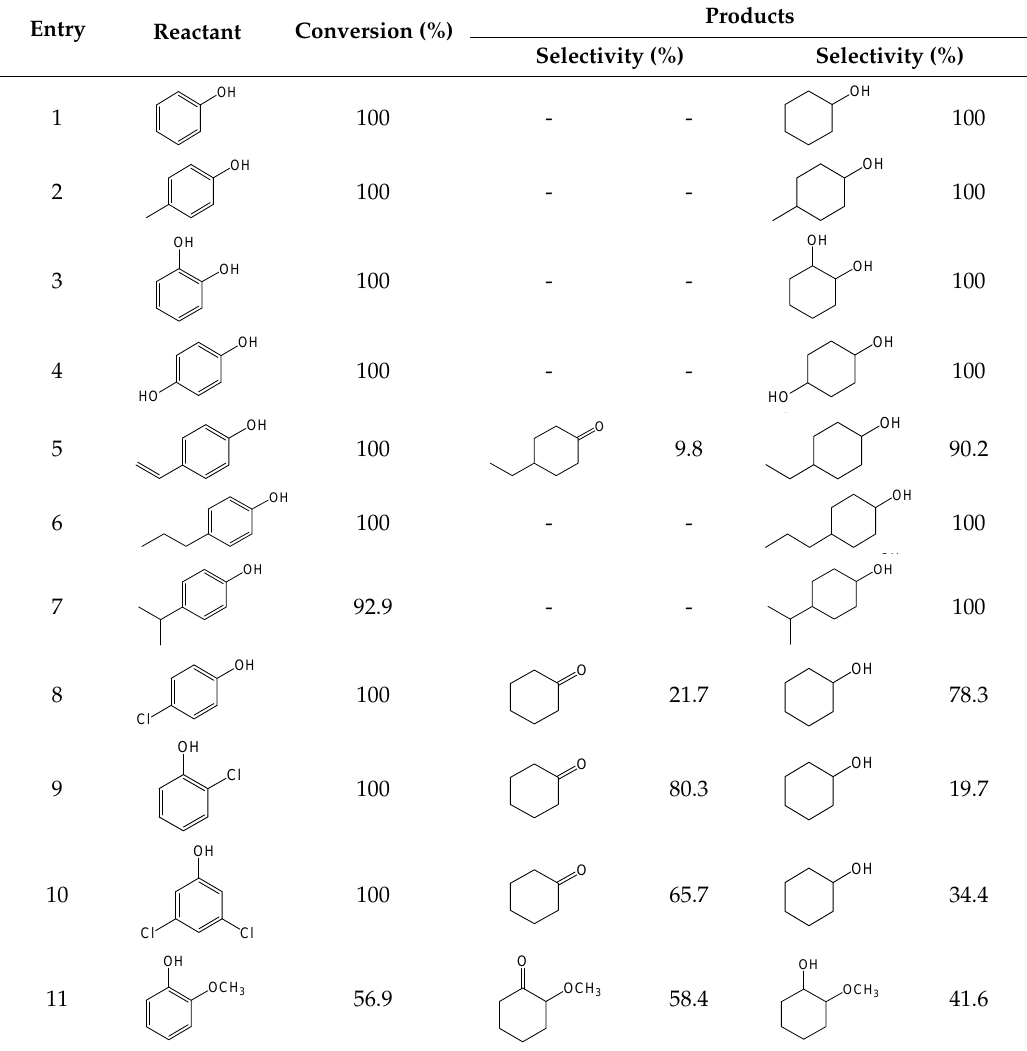
Table 3. The catalytic efficiency of the catalysts on the hydrogenation of different lignin-derived monophenols a . Entry Reactant Conversion (%) Products